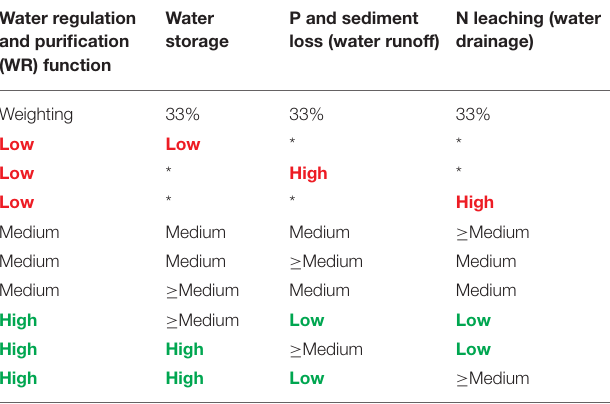
TABLE 2 | Integration rules used to classify the water regulation and purification (WR) soil function as “low,” “medium,” or “high” based on the determined capacity to store water and regulate P and sediment runoff and mitigate against N